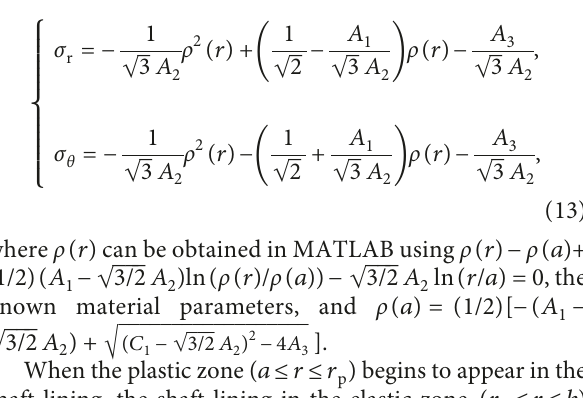
Figure 12: Mechanical model of concrete shaft lining.